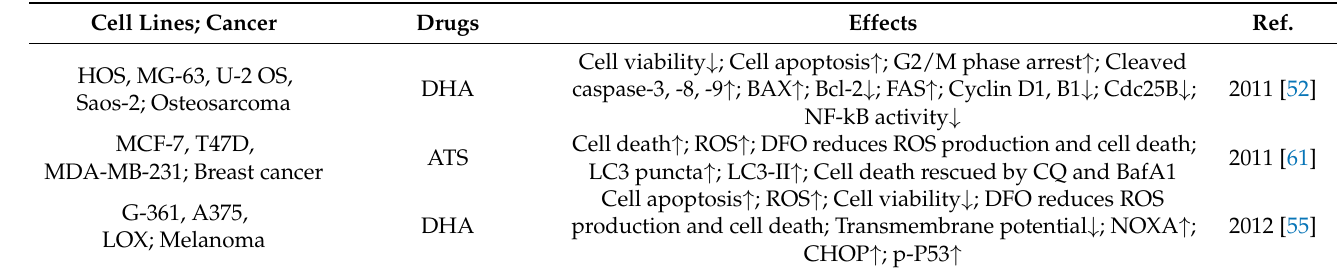
Figure 2. Artemisinin-type drugs influence several RCD pathways. The red arrows represent the upregulation or downregulation of certain key players on protein level. ( I ) ART-type drugs produce ROS resulting in increased expression of death receptors, and cleavage of caspase-3 and caspase-8, and decreased c-FLIP expression, leading to stimulation of the extrinsic apoptosis pathway. Meanwhile, ROS itself also triggers the intrinsic apoptosis pathway by upregulating the expression of tBID, BAX/BAK, inducing the release of Cytochrome C to activate caspase-9. ( II ) ROS accumulation from ART-type drugs results in lipid peroxidation to induce ferroptosis. Besides, the disruption of the oxidative homeostasis maintaining system by ART-type drugs leads to downregulation of GPX4 expression. ( III ) The oxidative stress from ART-type drugs initiates the formation of the phagophore via activating the AMPK pathway and assembling the VPS34 complex, resulting in autophagy. ART-type drugs also increase MLKL pore formation to induce necroptosis ( IV ), or GSDME-NT pore formation to induce pyroptosis ( V ). Table 1. List of studies from the last 10 years investigating the effect of ART-type drugs related to apoptosis in cancer cells with information on the model systems used, the ART-type drugs tested and the major findings of the study.